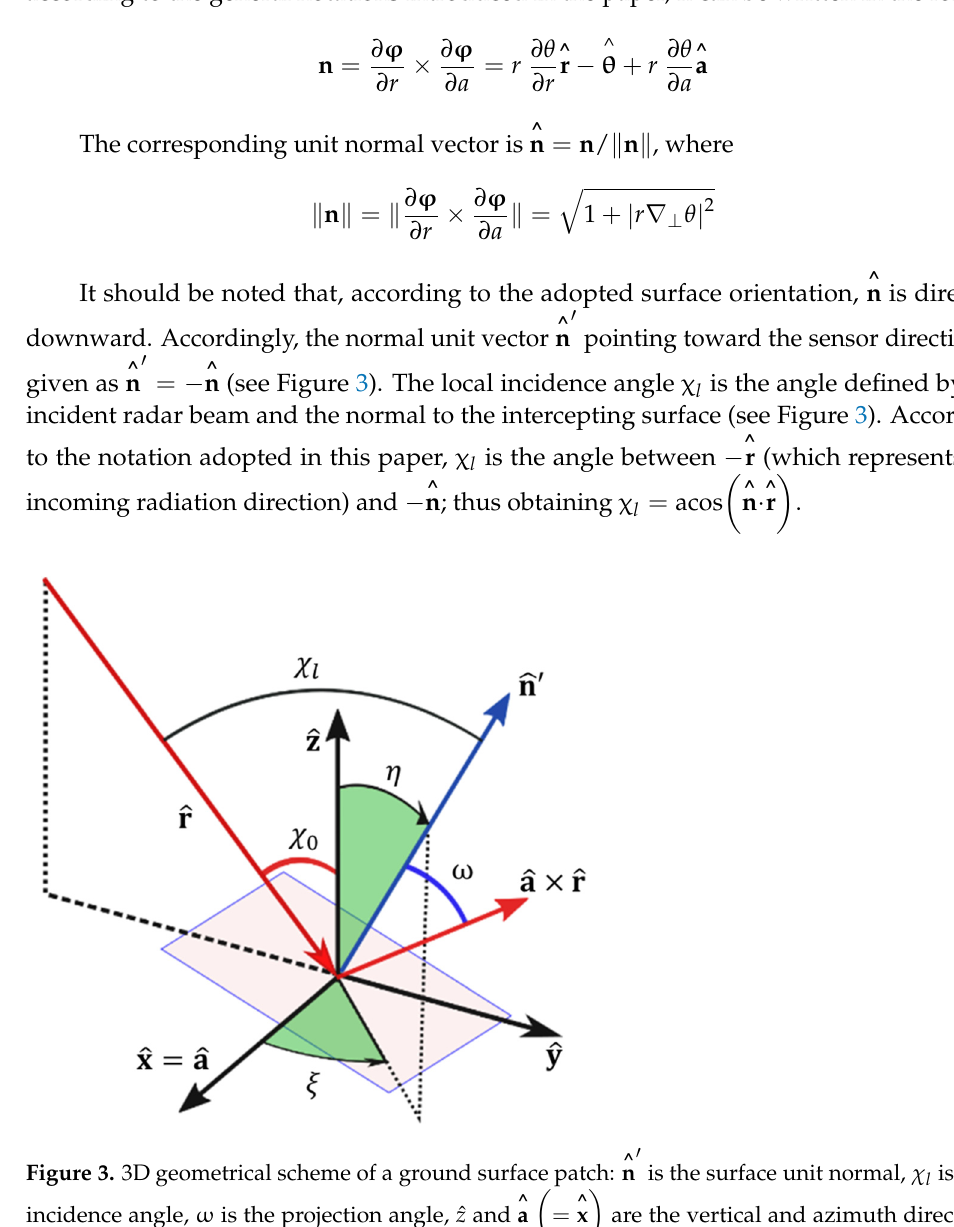
Figure 3. 3D geometrical scheme of a ground surface patch: 𝐧(cid:3549) (cid:4593) is the surface unit normal, 𝝌 𝒍 is local incidence angle, ω is the projection angle, 𝒛(cid:3548) and 𝐚(cid:3548) (= 𝐱(cid:3548)) are the vertical and azimuth directions, respectively.